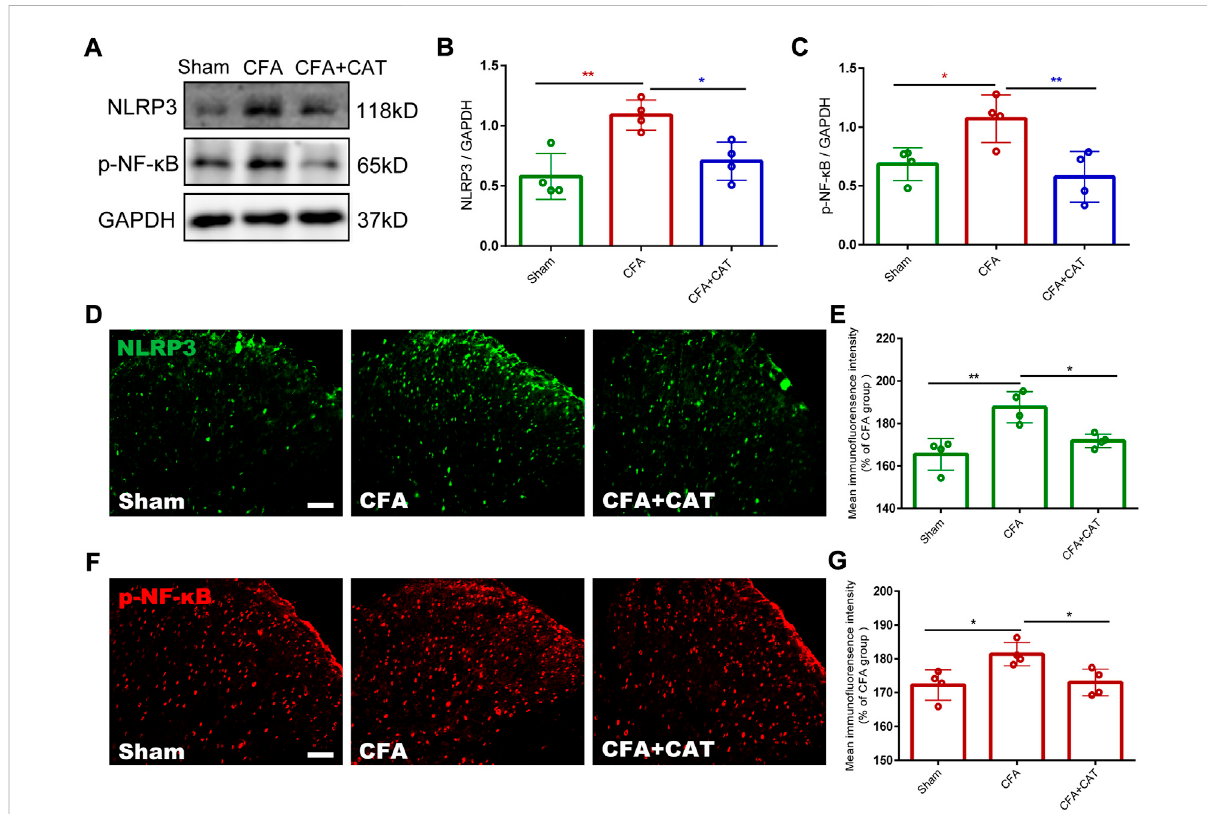
FIGURE 5 Effect of Catalpol on expression of NF- κ B/NLRP3-in fl ammatory axis in the spinal cord of CFA rats. (A – C). The protein expressions of p-NF- κ B and NLRP3 in the spinal cord of rats were detected by Western blotting. (* p < 0.05, ** p < 0.01, vs. the CFA group; n = 4, one-way ANOVA). (D,E). The fl uorescence intensity of NLRP3. (F,G). The fl uorescence intensity of p-NF- κ B. (* p < 0.05, ** p < 0.01, vs. the CFA group; n = 4, one-way ANOVA). Scale bar = 50 μ